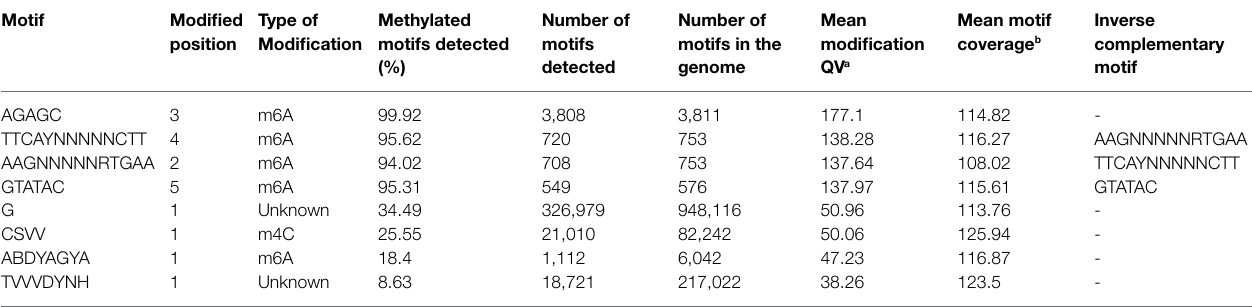
TABLE 5 | Methylated motifs detected in C. septicum DSM 7534 T